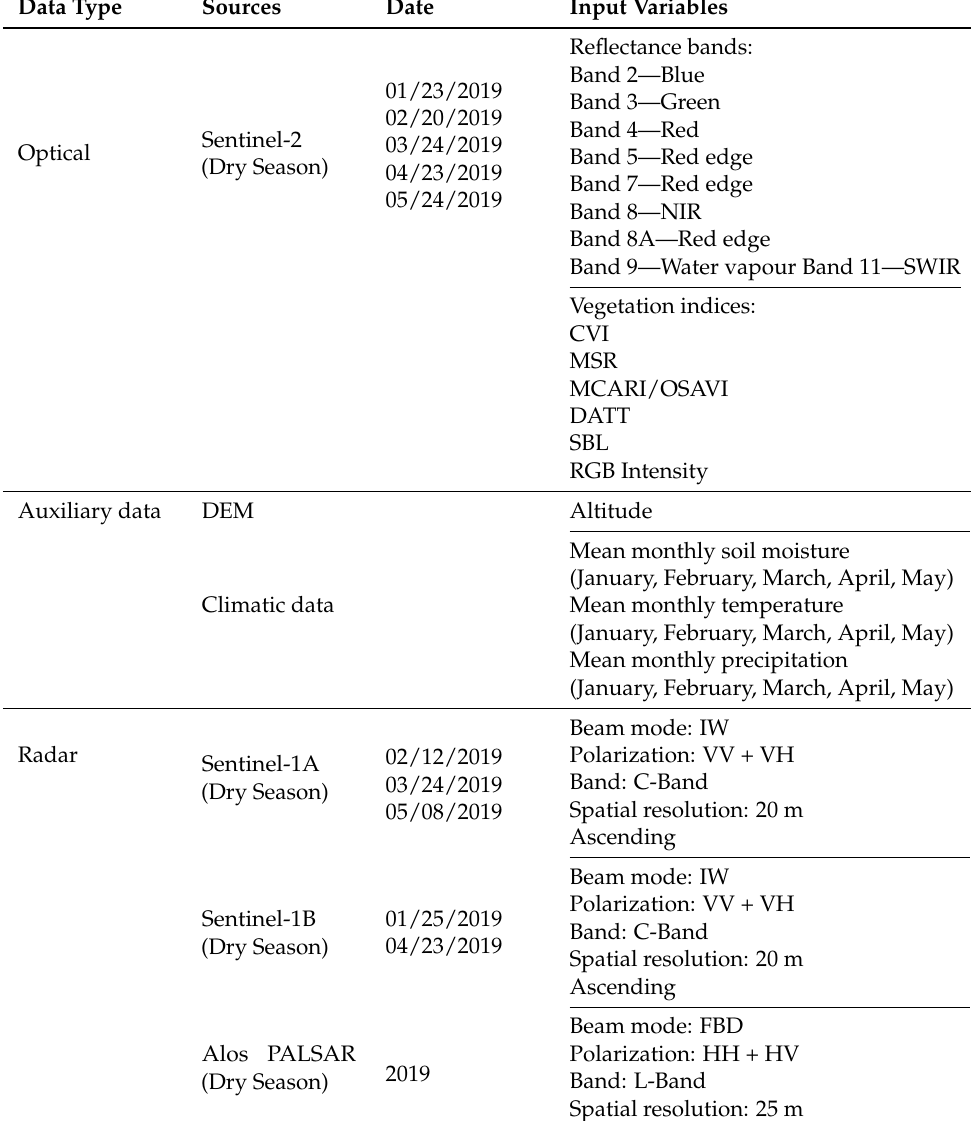
Table 3. Data used for the identification of coffee agroforestry